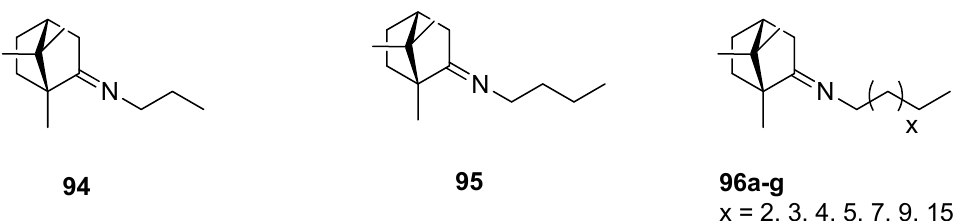
Figure 24. Aliphatic ( + )-camphor imines with various lengths of the aliphatic chain.